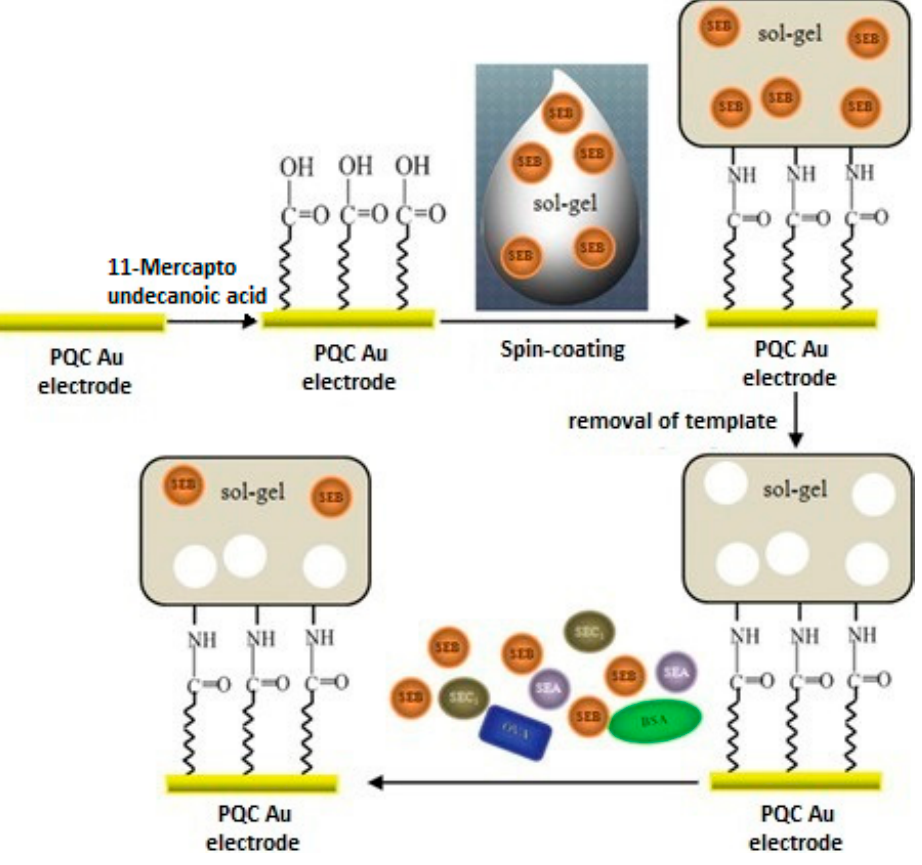
Figure 3. Schemes of the preparation of sol-gel imprinted thin film on the surface of the piezoelectric quartz crystal (PQC) Au-electrode for the detection of staphylococcal enterotoxin B (SEB) (reproduced with permission from [19]).